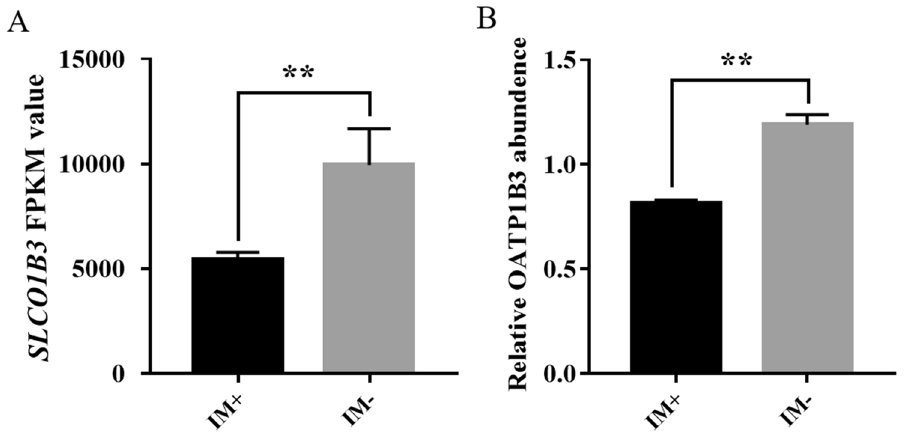
Figure 2. SLCO1B3 ( A ) and OATP1B3 ( B ) expression in the transcriptome and proteome. The expression of SLCO1B3 and OATP1B3 of IM+ individuals have about 1/twofold than that in IM− individuals. IM+ chickens